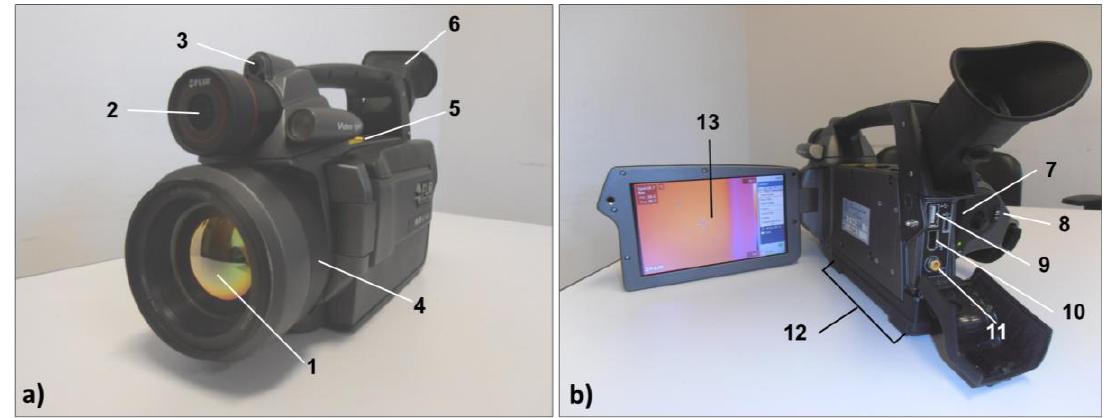
Figure 2. FLIR SC620 Thermal camera front view ( a ): 1 = germanium lens; 2 = digital camera; 3 = laser pointer; 4 = manual focus ring; 5 = control buttons; 6 = tiltable viewfinder. Back view ( b ) (7 = SD-card slot; 8 = built-in software buttons; 9 = USB connector; 10 = firewire connector; 11 = video connector; 12 = battery; 13 = LCD screen).